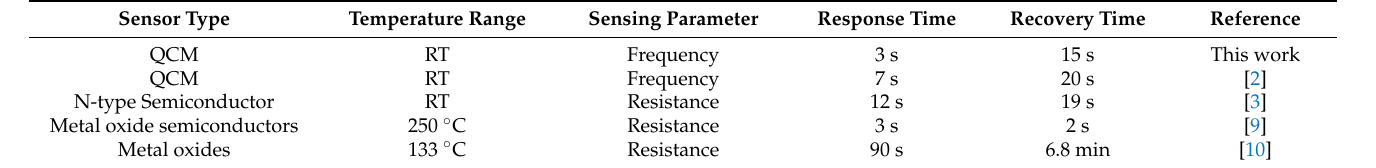
Table 2. Comparison of different types of TMA